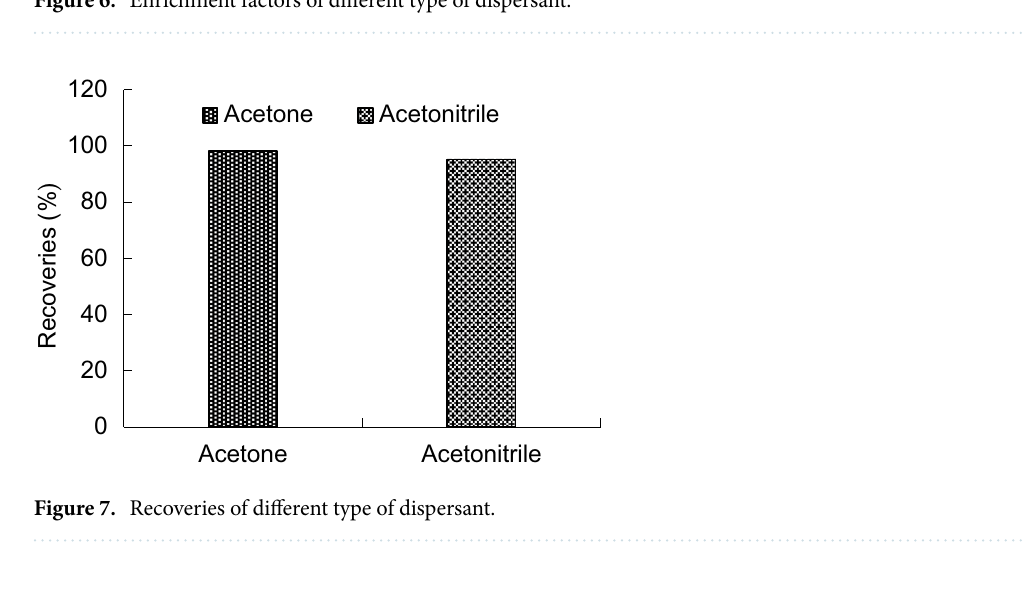
Figure 6. Enrichment factors of different type of dispersant.